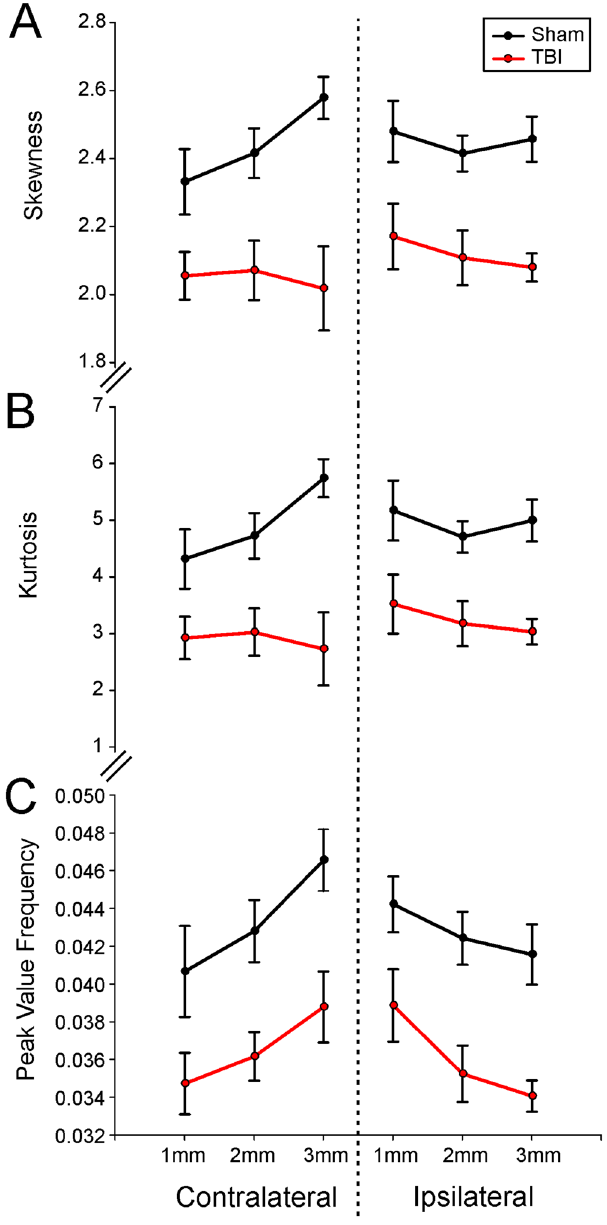
Figure 5. Fractal analyses of the ipsilateral and contralateral brain demonstrate widespread alterations in vasculature complexity and frequency after brain injury. ( A ) The average skewness for radial concentric circles located in the ipsilateral injury site and contralateral corresponding brain region demonstrate a widespread decrease in vascular complexity (skewness) compared to shams. ( B ) Similarly, the average kurtosis from ipsilateral and contralateral brain regions displayed a similar distribution and pattern as found for skewness. ( C ) The average peak frequency value for each concentric circle ipsilateral and contralateral to the injury site confirms a reduction in the complexity of the vasculature in TBI animals compared to shams. Interestingly, the focal injury reductions in the complexity of the vasculature are observed uniformly not only at the ipsilateral injury site but also on identical contralateral brain